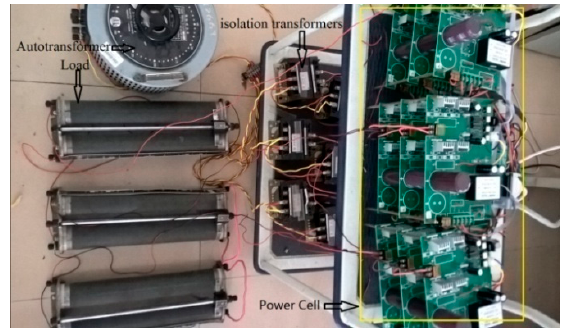
Figure 18. Experimental setup.